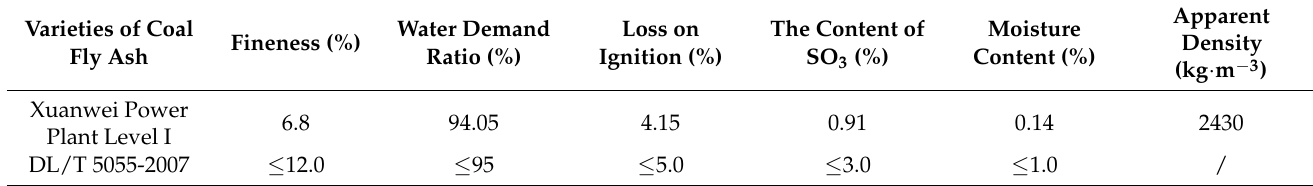
Table 4. Quality test results of fly